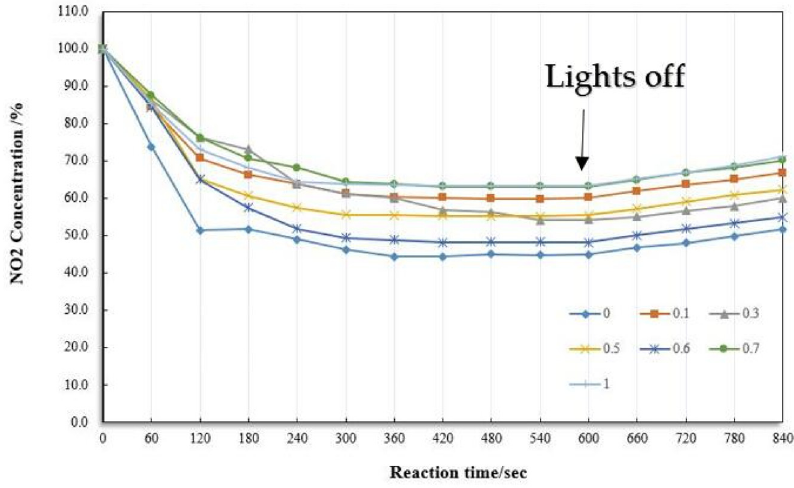
Figure 11. NO 2 degradation efficiency under different Active Carbon/TiO 2 ratios.